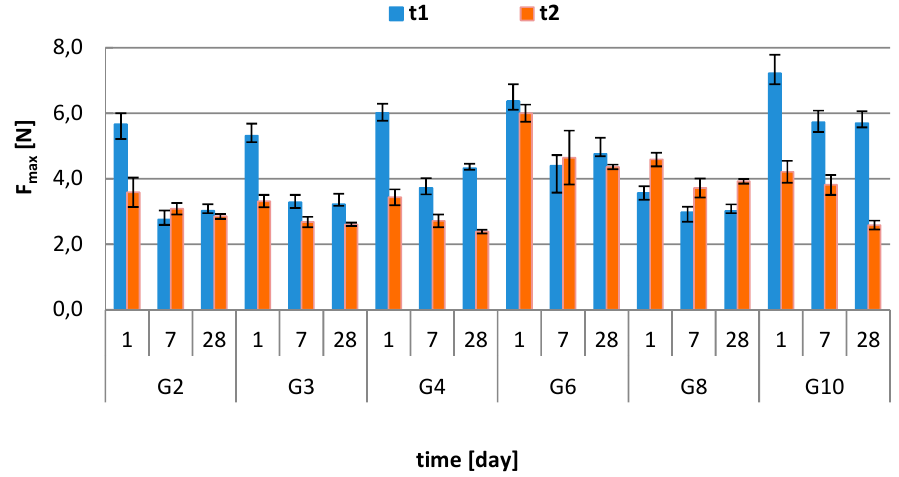
Figure 1. Maximum mechanical strength to compression of capsules of different goethite contents after keeping them in deionized water (WD), t1 = 4 °C; t2 = 20 °C.